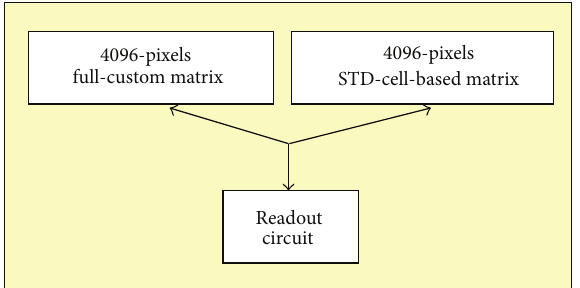
Figure 26: Apsel4D operating modes: custom mode and digital